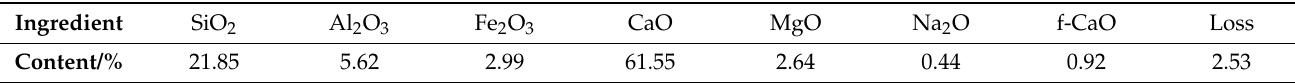
Table 1. Chemical composition of